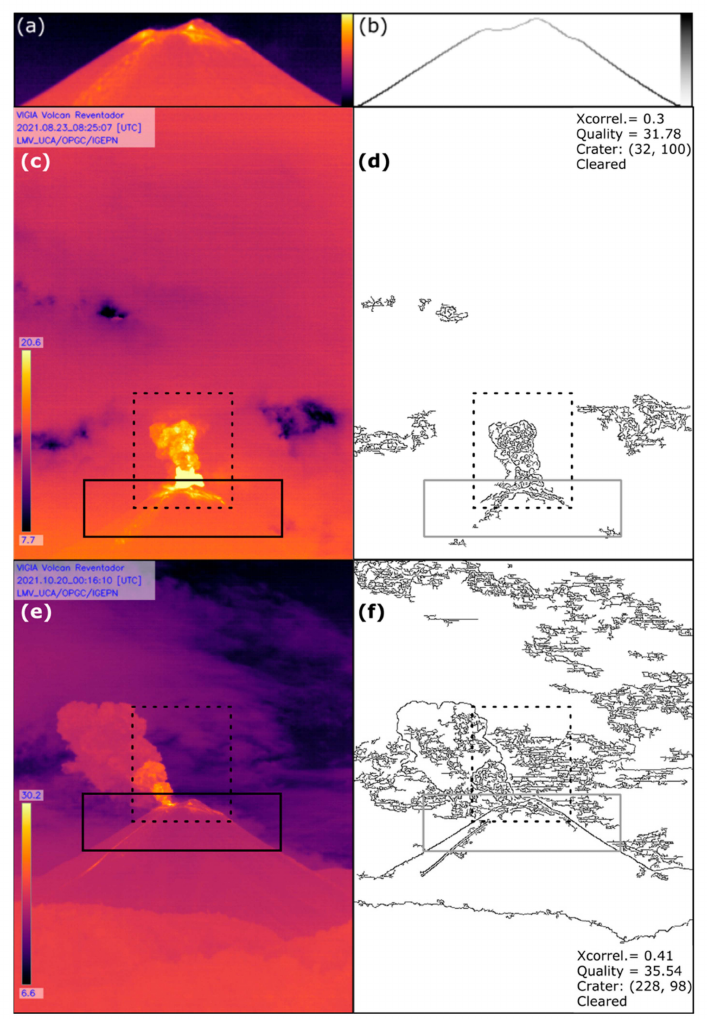
Figure 5. From a clear image of the upper cone ( a ), we extracted the outline of the volcano and used it to recognize the volcano in each captured image. Panel ( b ) shows the mask used in the normed 2D cross-correlation algorithm that determines whether or not the volcano appears in each new captured image. The colour scale in panel ( a ) represents the temperature and the grayscale in panel ( b ) represents the weight (importance) of the template pixels. In each captured image ( c , e ), the volcano recognition algorithm obtains the contours ( d , f ) and cross-correlates them with the masked template ( b ). The solid-line squares show the position of the volcano found. The normalised cross-correlation coefficient, the quality, the location of the crater as a row-column pair from the lower left corner, and the result of the recognition are shown for an image of the Reventador volcano in August 2021 ( c , d ) and in October 2021 ( e , f ), after the camera was moved slightly downwards. The algorithm is independent of the displacement of the cone within the image. The quality factor is calculated from the number of features (contours) and the range of temperature inside the dashed-line